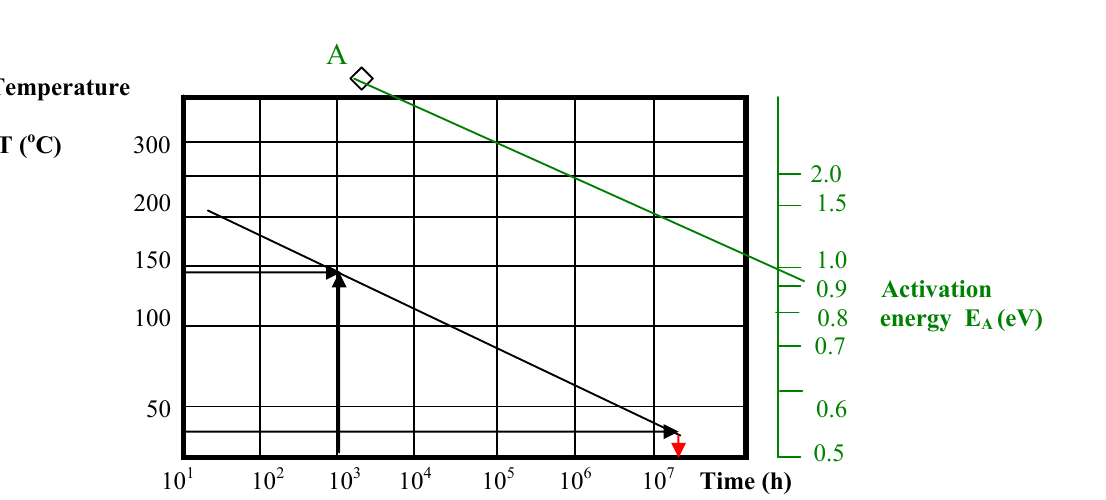
Figure 5. Lognormal probabilistic paper for calculating the median time of the failure distribution for fatigue fracture.